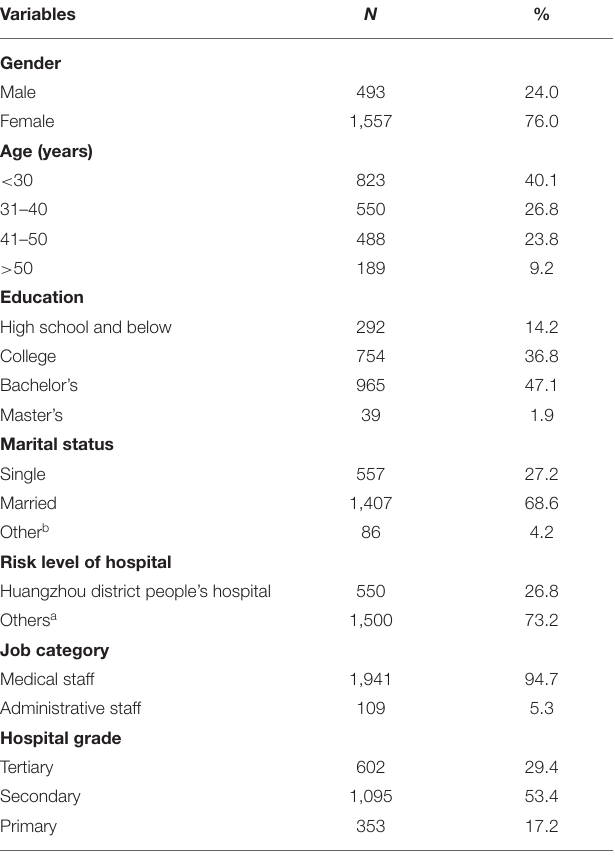
TABLE 1 | Baseline characteristics of study participants ( N =